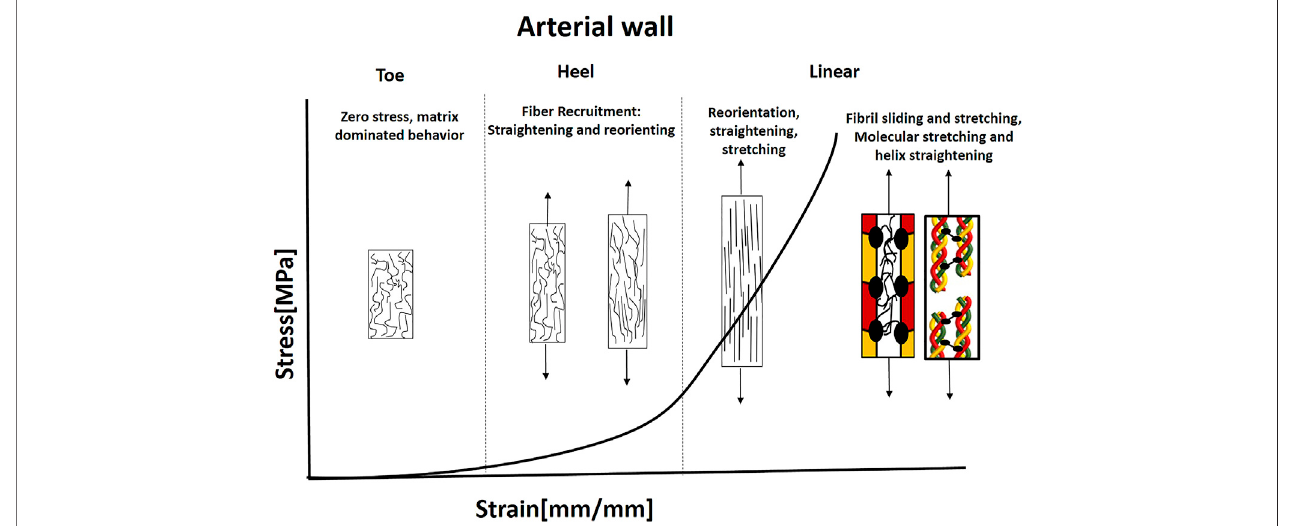
FIGURE8| IllustrationoftheJ-shapedbehaviorandmechanicalmechanismsundertensionintheaorta.Thecollagen fi bersareseparatedandnoncontinuouswith preferred orientation. The distribution of orientations islarger than AF, ligaments, and tendons. Elastin iswidely distributed and carries the load under smallstrains. Fiber recruitmentstartsintheheelregion(Hilletal.,2012).Fibersneedtoreorientandstraighttocarrytheload;therefore,largerdeformationsexist.Then,simultaneoussliding and stretching start, mediated by PGs. This stage is followed by a molecular stretch of the covalent cross-links and helix straightening taking place.